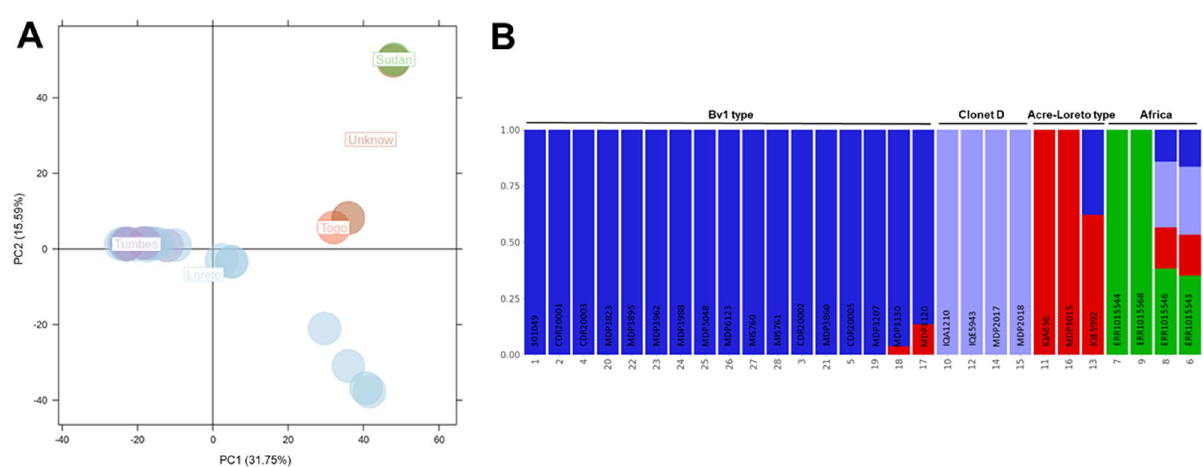
Figure 4. Population structure of P. falciparum samples. ( A ) Principal component analysis (PCA) showing three potential clusters for samples from Tumbes and Loreto. ( B ) Admixture analysis confirms the presence of these three Peruvian subpopulations, one of these (blue) that included all Bv1-type samples from the Peruvian Amazon Basin and North Coast regions and the other two corresponding to Clonet D and Acre-Loreto type, respectively. African reference samples were included as